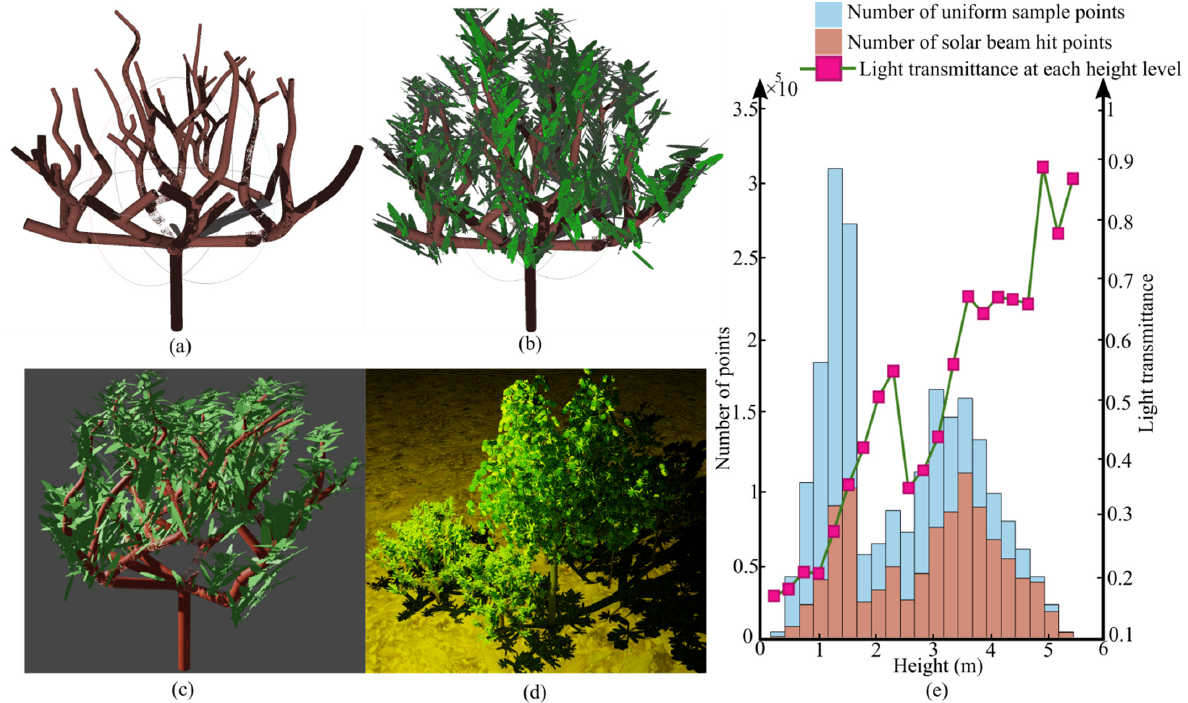
Figure 7. The schematic diagram draws the light simulation of the forest plot based on the proposed framework. ( a , b ) The exhibition of branch and leaf sampling points of a single tree. ( c ) The light simulation of a single tree where light originates from the top left. ( d ) Light simulation of the mod ‐ eling forest plot with a solar azimuth angle of 179.01° and an altitude angle of 62.88°. ( e ) The light transmittance of the forest plot under the solar beams at each height interval, where distribution histograms illustrate the number of uniform sampling points (blue color) and solar beam hit points (red color) at each height level, respectively, and the line chart represents the light transmittance at each height level.